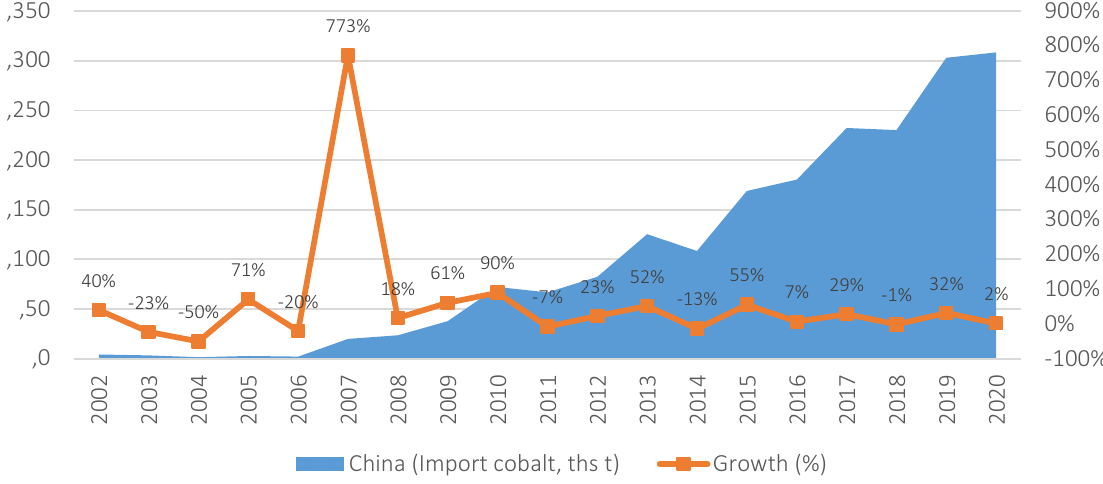
Figure 5. Cobalt imports by China for the period 2002–2020 (ths t)